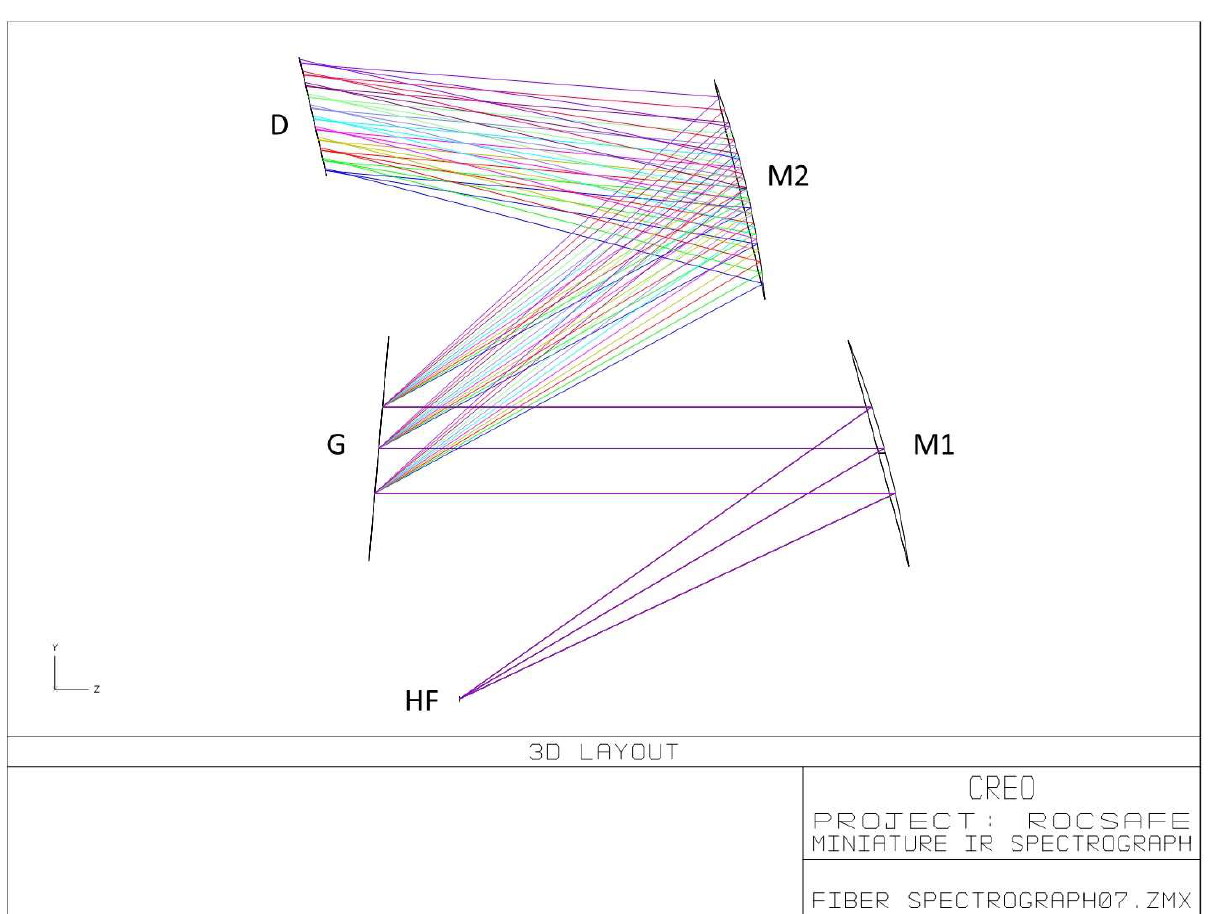
Figure 5. Optical scheme of the miniature IR spectrograph, where HF is the exit aperture of the hollow fiber; M1 is a 30 deg. off-axis parabolic mirror; M2 is a spherical mirror; G is the diffraction grating; D is the sensitive surface of the LDA.